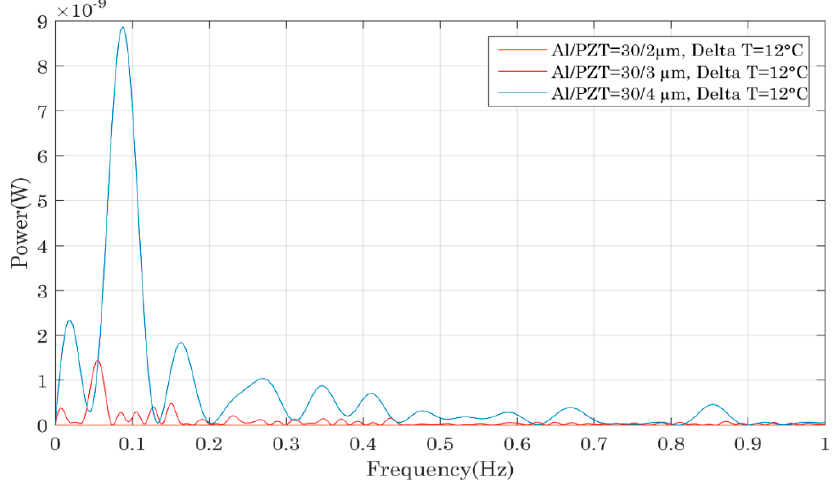
Figure 8. Impact of the PZT thin film thickness on the output power of the piezoelectric bimetal mounted in the device as shown in Figure 7.